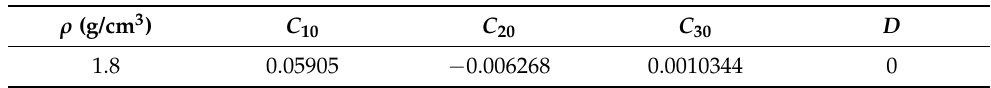
Table 3. Material property of rubber.